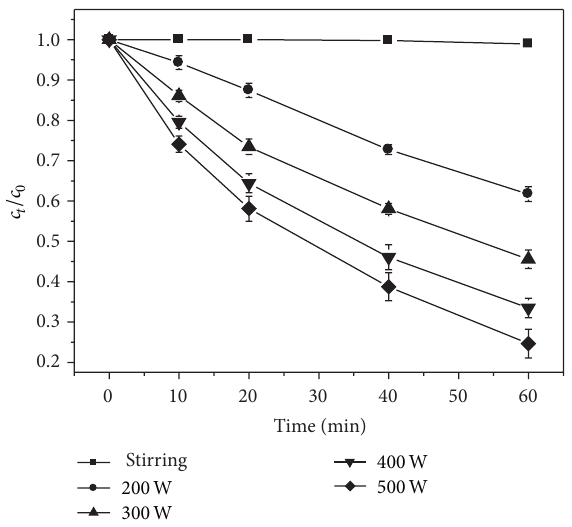
Figure 3: Effect of ultrasonic power on the degradation of fuchsin basic (initial dye concentration = 10 𝜇 molL −1 , ultrasonic frequency = 25 kHz, tempetature = 22 ∘ C, pH = 6.5).